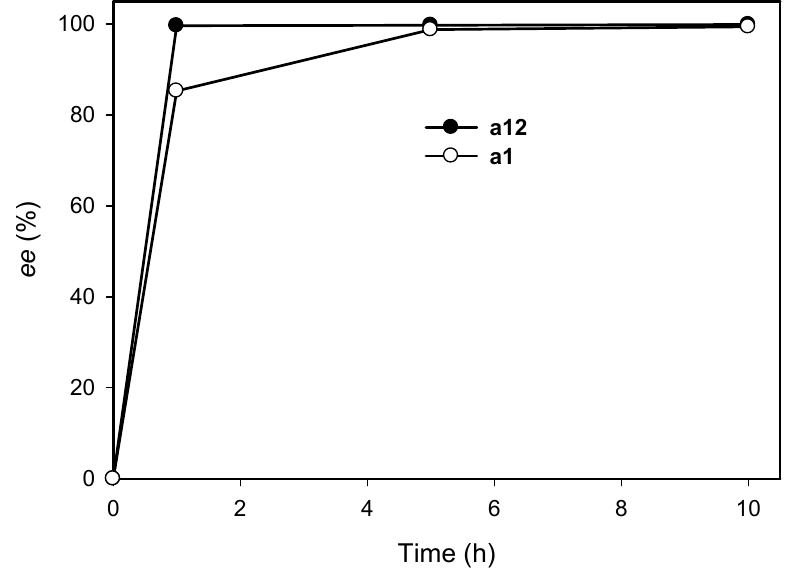
Figure 9. Reaction profiles of the kinetic resolution of 50 mM a12 or 20 mM a1 . Sixty milligrams (60 mg) and 100 mg DCW/mL of whole ‐ cell was used for the reaction of 50 mM a12 or 20 mM a1 , respectively.